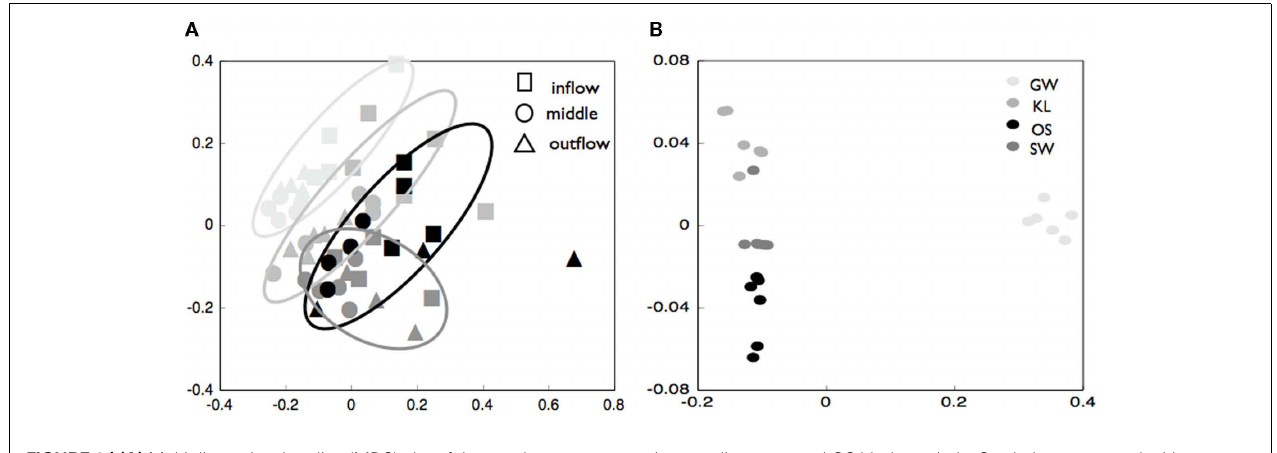
FIGURE 2 | (A) Multi-dimensional scaling (MDS) plot of Jacquard similarity index of terminal-restriction fragment length polymorphism data for community biofilms from the inflow, middle, and outflow section of each reactor as noted in the figure legend.The GW treatment is plotted is in the lightest color, with KL light gray, SW